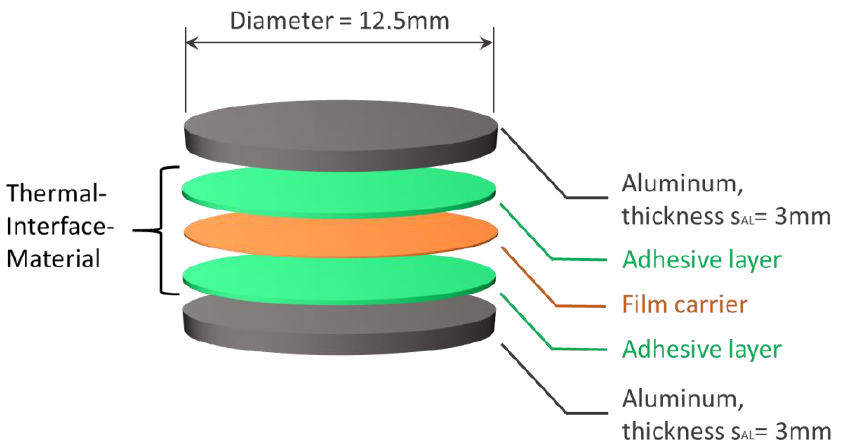
Figure 6. Structure of the LFA multilayer samples.